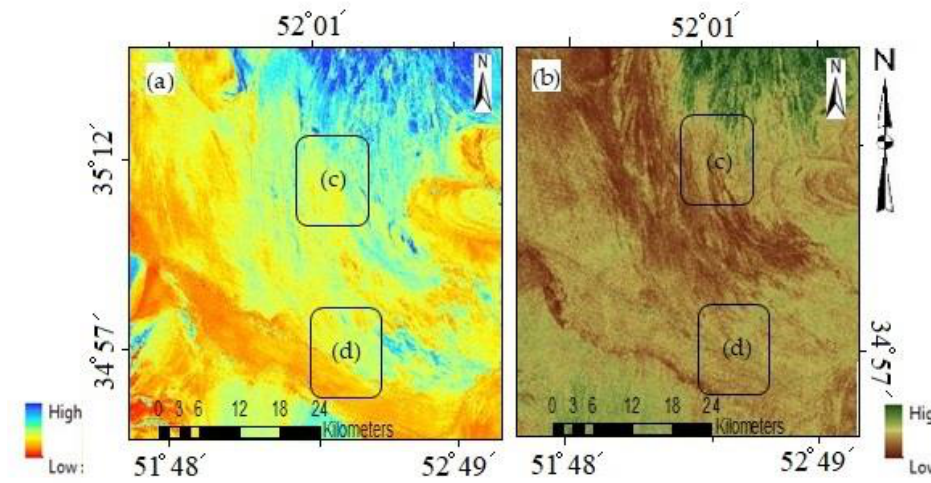
Figure 10. The result of NWI ( a ) from low to high water content and NDVI ( b ) from low to high vegetation cover using Landsat data. The rectangles (c,d) correspond to the same position of rectangles in the Google Earth image in Figure 9.